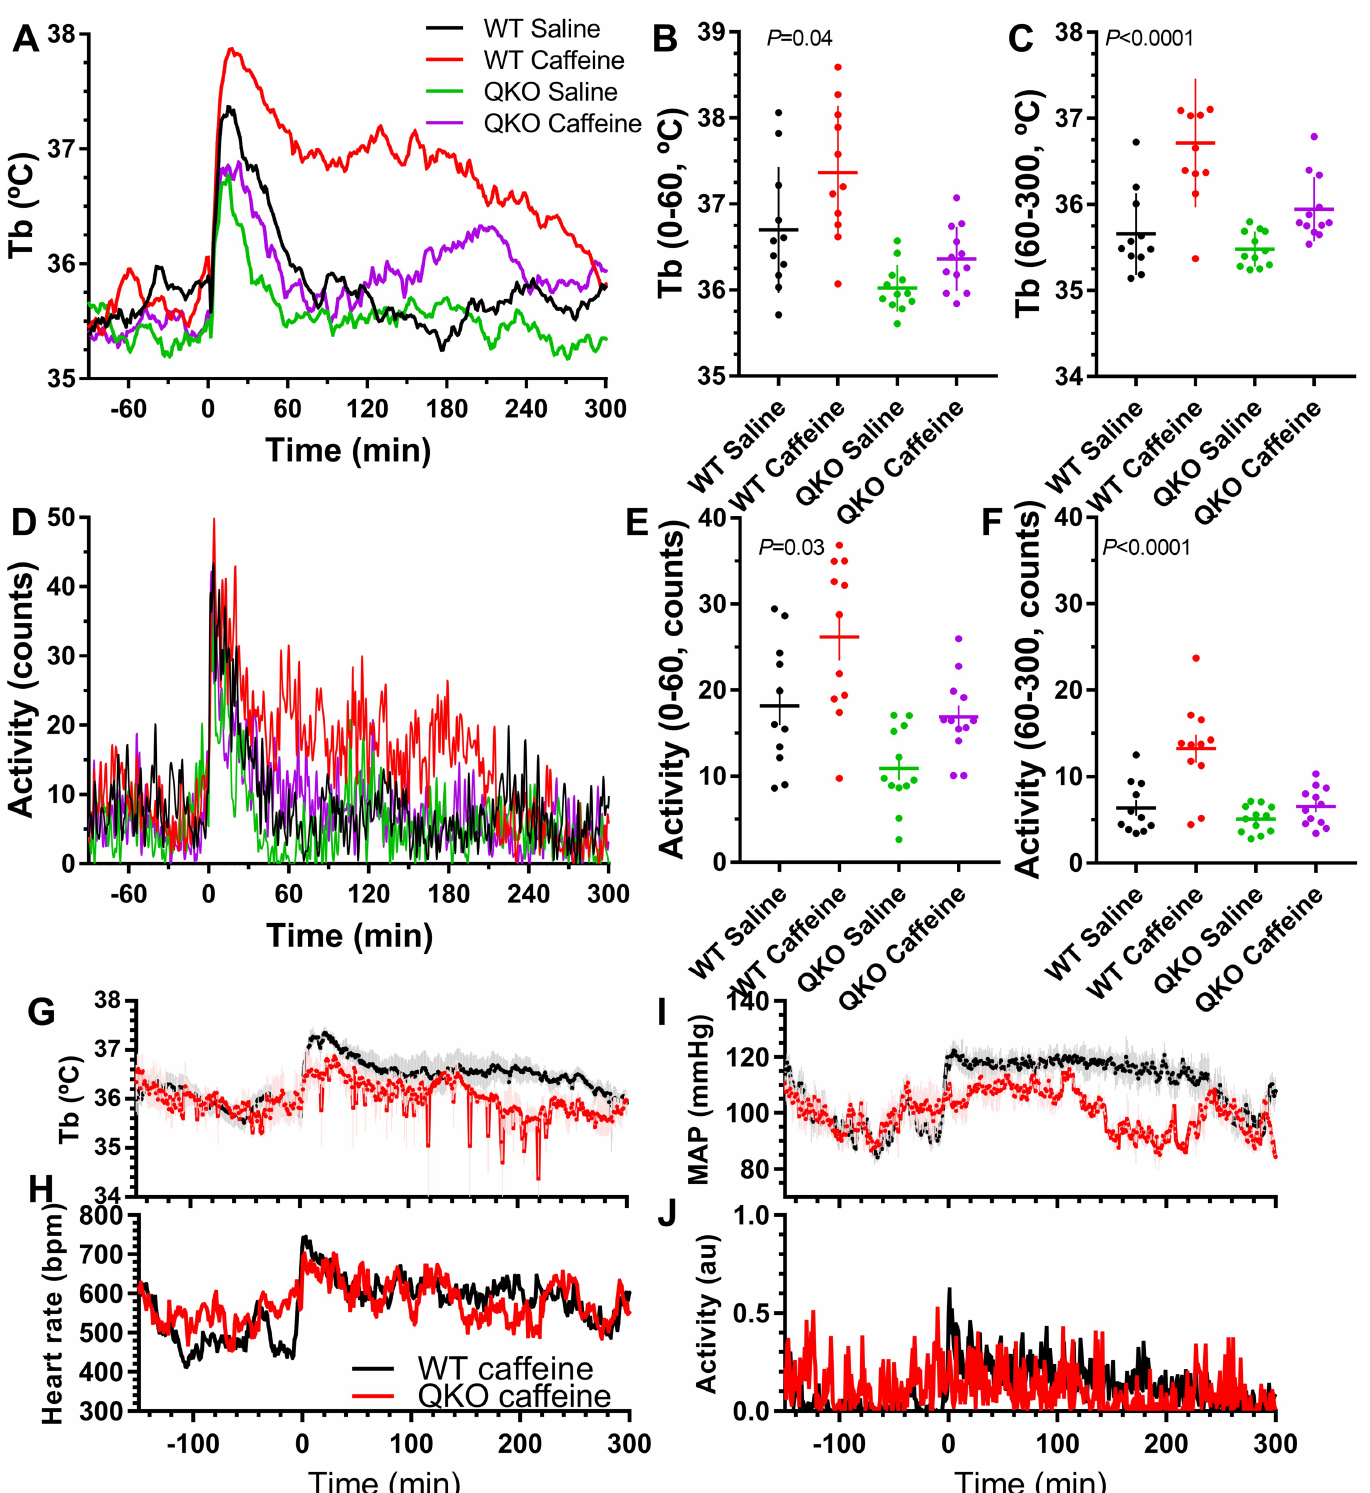
Fig 6. Tb and activity effects of caffeine are lost in QKO mice. (A-F) Male QKO and control mice were treated with caffeine (30 mg/kg, i.p.) or saline. Adjusted P values (from two-way ANOVA with Sidak multiple comparisons test; N = 11–12/group) are for effect of vehicle versus caffeine in control mice; caffeine effect was not significant in QKO mice. (G-J) Cardiovascular effects of caffeine (30 mg/kg, i.p.) or saline in female QKO mice ( N = 3–5/group; statistics in S6 Table). The numerical data are in